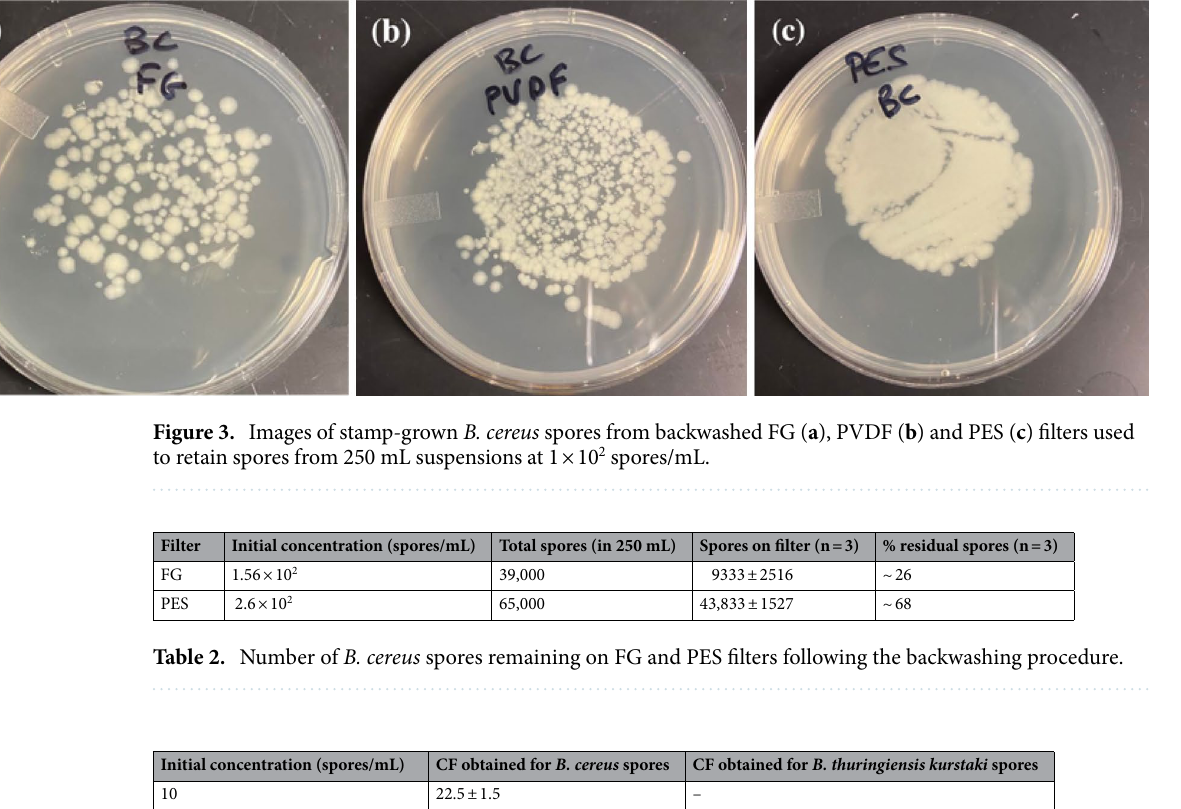
Initial concentration (spores/mL)